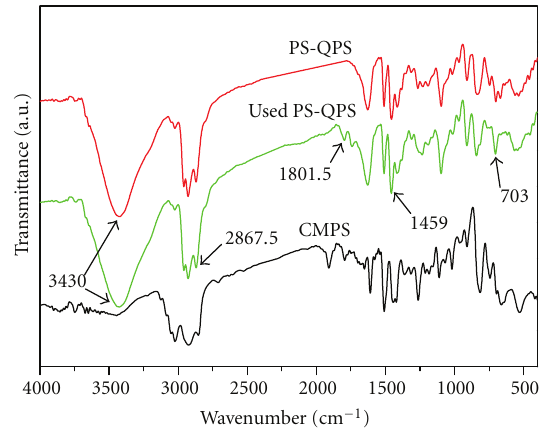
F 1: FT-IR spectra of chloromethylated bead and PS-QPS.